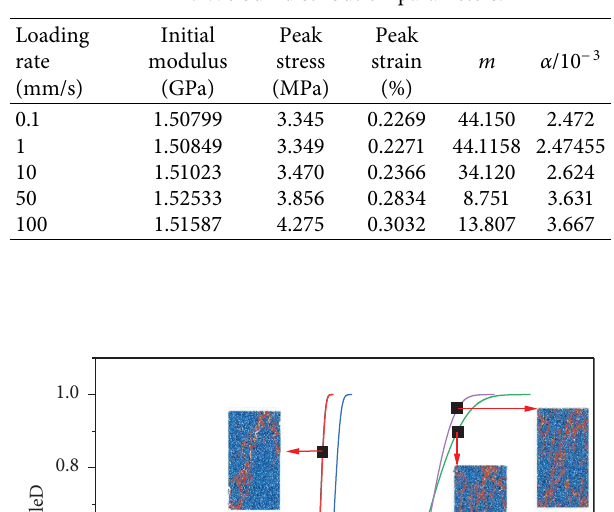
Table 4: Weibull distribution parameters.